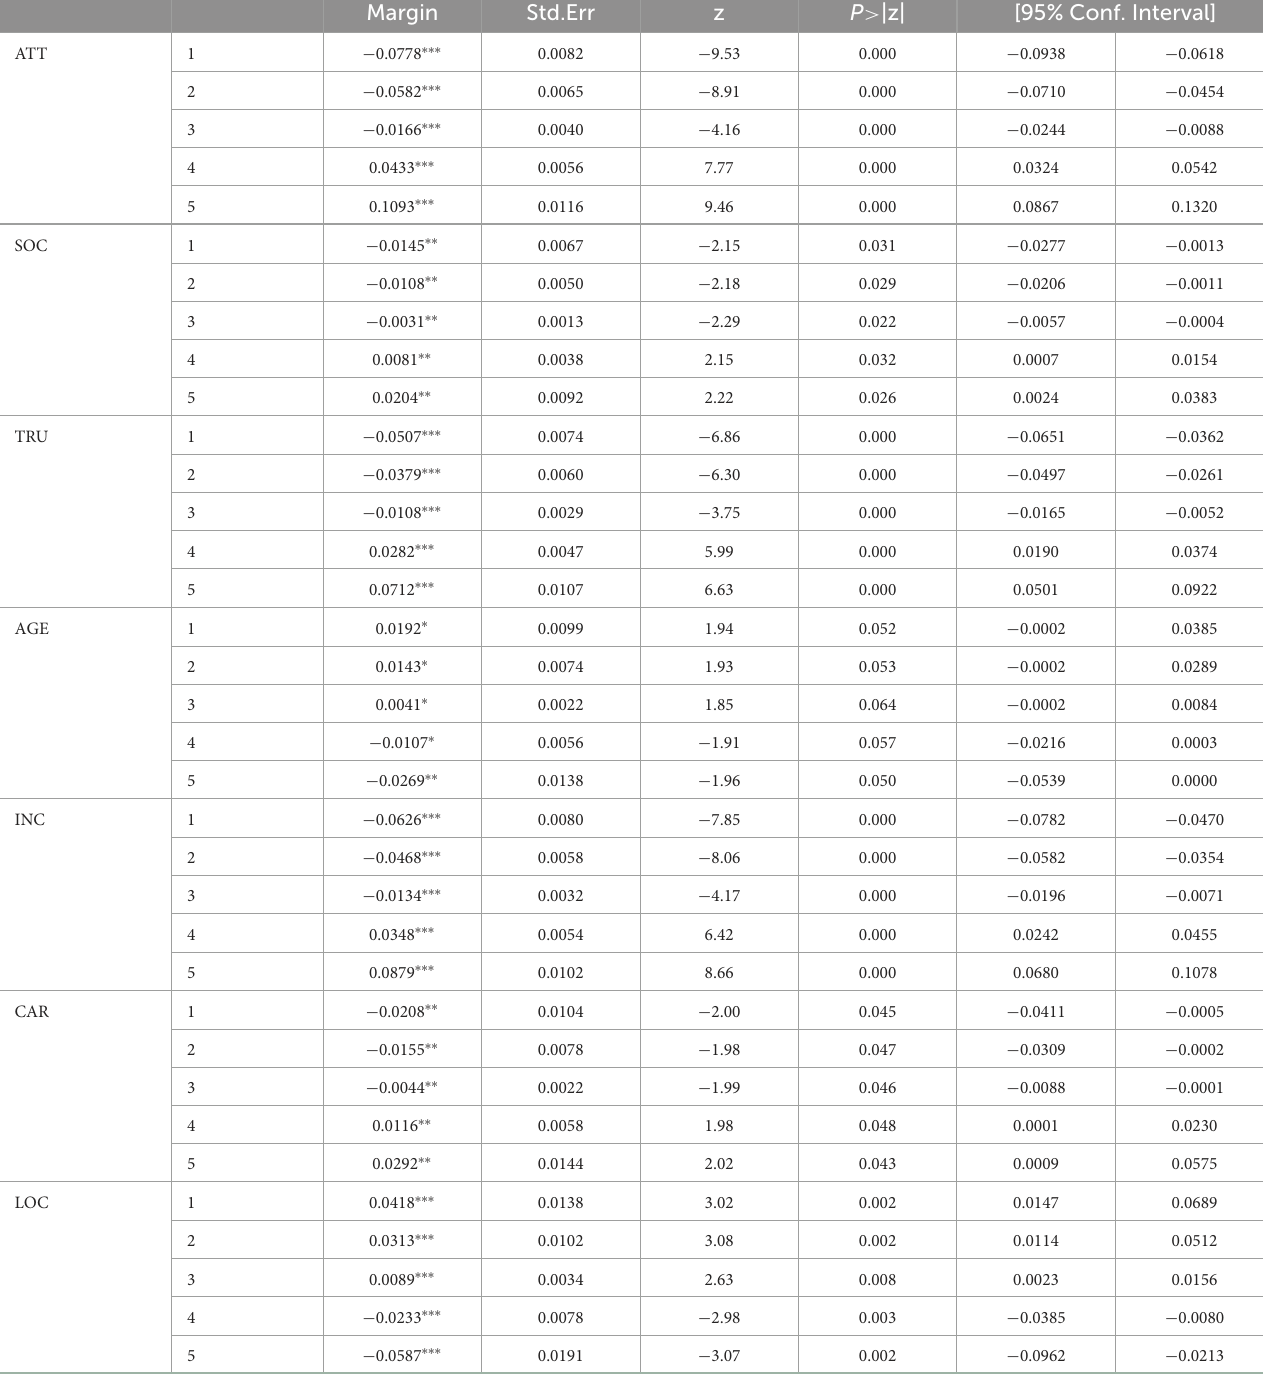
TABLE 5 Marginal effects of different factors after the epidemic.